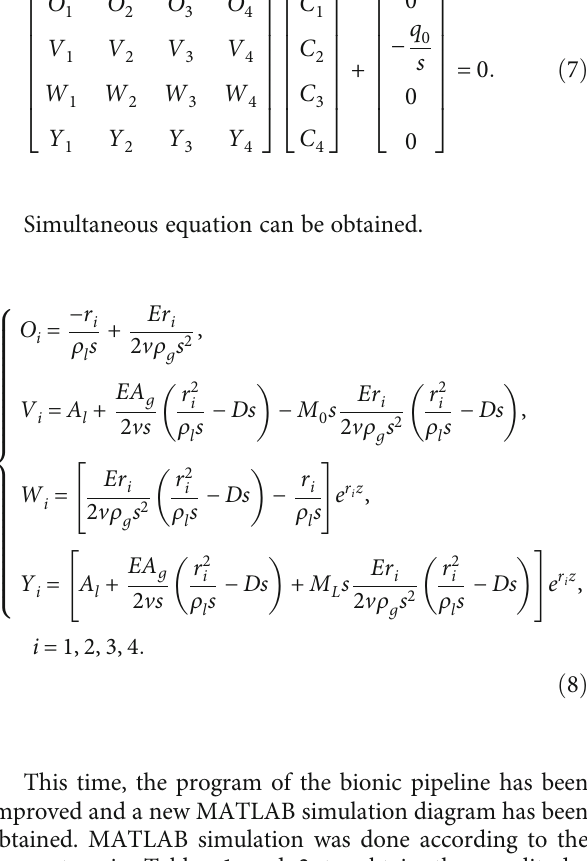
Table 1: Parameter table. Parameter category Table Sectional area of pipe wall sectional area of